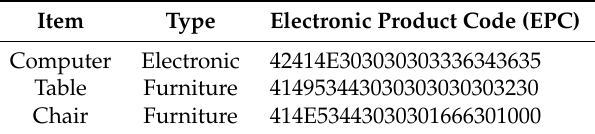
Table 1. Result of a query in the Asset microservice